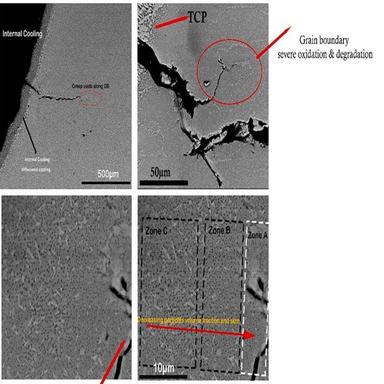
Internal cracking near the LE cooling holes detected after 75,000 h (at the 25% height).